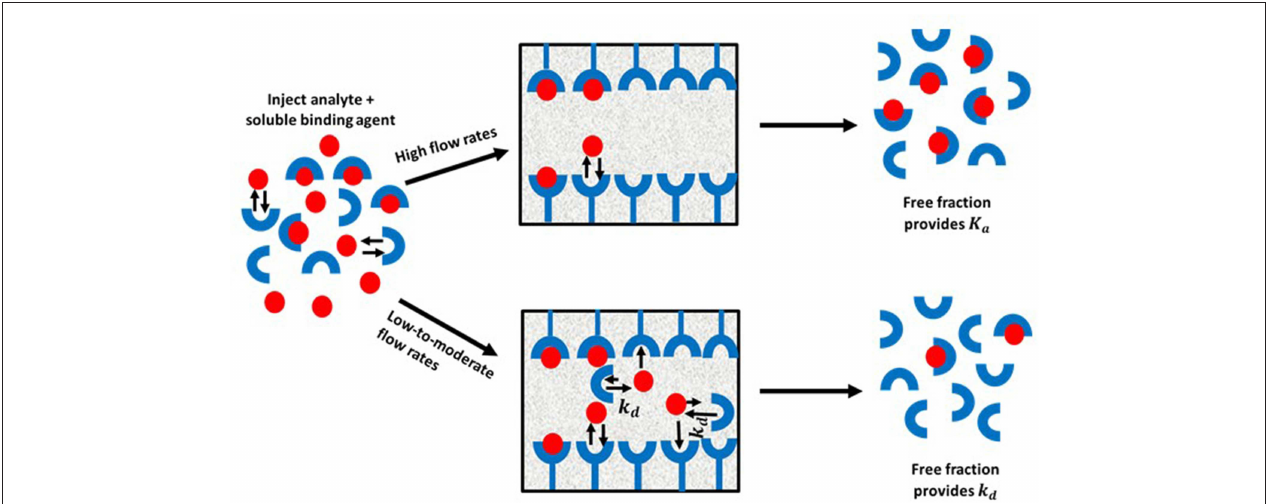
FIGURE 11 | General scheme for studying analyte interactions with a soluble binding agent by using ultrafast affinity extraction. Terms: K a , association equilibrium constant; k d , dissociation rate